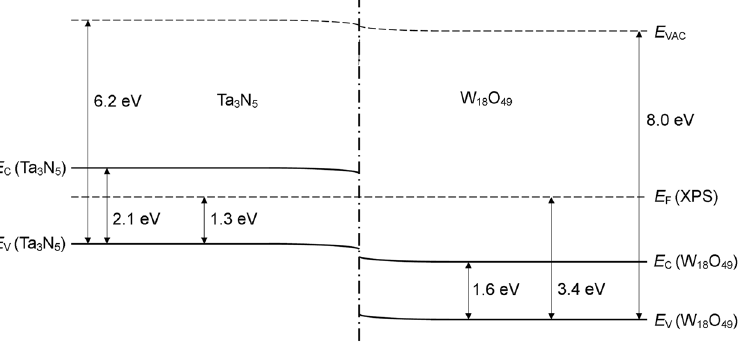
Figure 7. Proposed band structure of Ta 3 N 5 /W 18 O 49 , constructed using estimates of the optical band gaps of Ta 3 N 5 and W 18 O 49 from Fig. 6, as well as E IP estimates from Fig. 5d and e, and the estimated electronic band gap of W 18 O 49 from Fig. 5b. The position of E F shown corresponds to the Fermi level estimated from the XPS valence band measurements in Fig. 5a and b; however, the true Fermi level of the isolated composite is not known, so the depicted position serves solely to illustrate the semi-metallic nature of the W 18 O 49